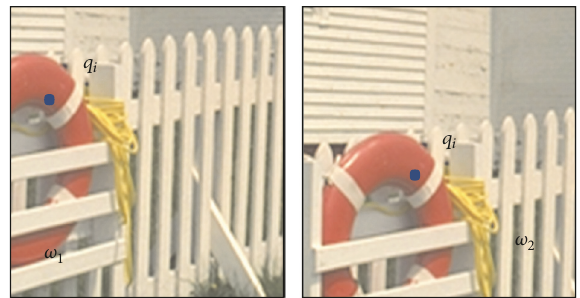
Figure 3: Illustration of (12). When the window 𝜔 is sliding in the image, a pixel is involved in many windows that covers pixel. For instance, windows 𝜔 1 and 𝜔 2 are different local windows that cover thesamepixel 𝑖 .Therefore,theoutput 𝑞 𝑖 shouldaverageallthevalues of pixel 𝑖 in different